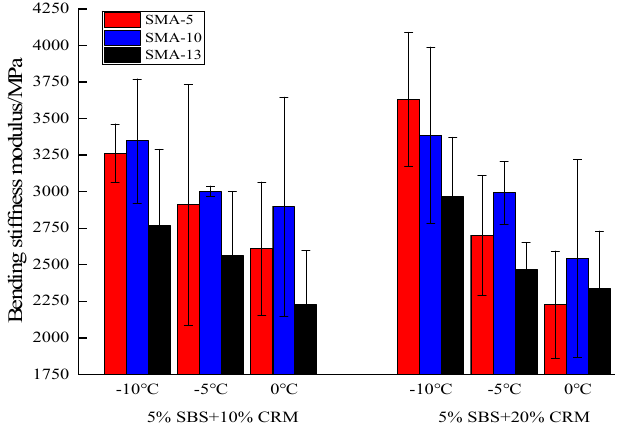
Figure 6. Bending fracture stiffness affected by NMS.